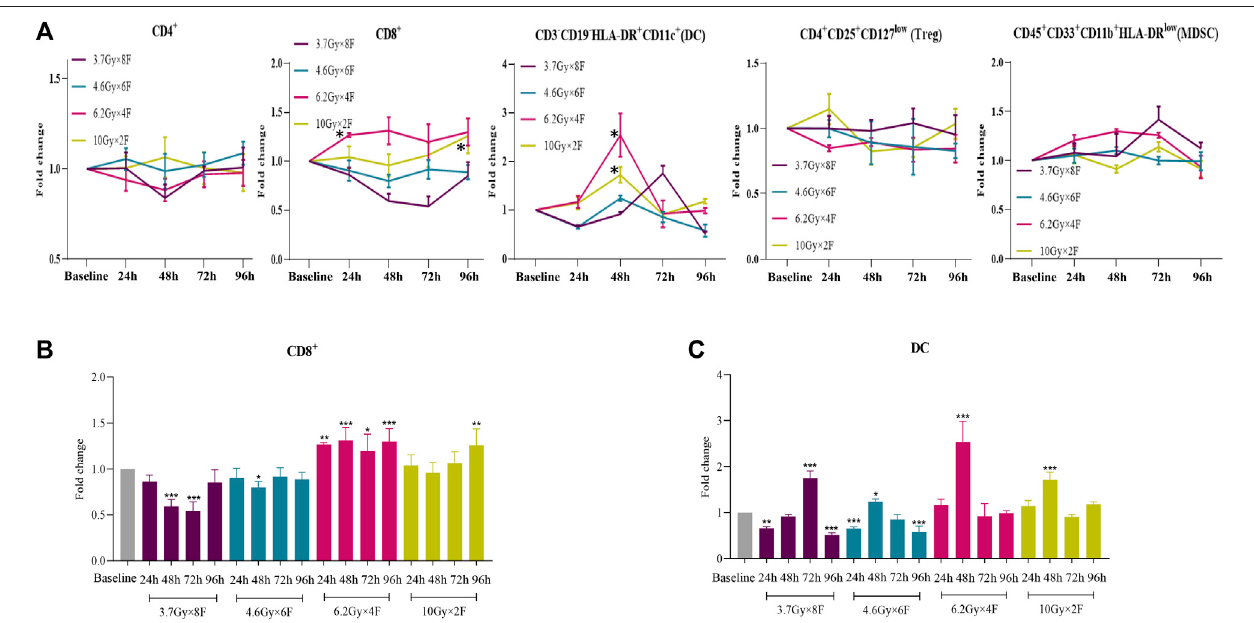
FIGURE5| DynamicchangesofdifferentimmunecellsafterradiotherapyinperipheralbloodofNSCLCpatients. (A) TrendsofCD4 + Tcells,CD8 + Tcells,DC,Treg, and MDSC after 4differentfractionation radiotherapies. *Thedose inwhich trendwassigni fi cantand thetime at whichdifference began. (B) Changes ofCD8 + Tcellsat different timepoints after radiotherapy, respectively. (C) Changes of DC at different timepoints after radiotherapy.* p ＜ 0.05,** p ＜ 0.01, *** p ＜ 0.001, compared with baseline.